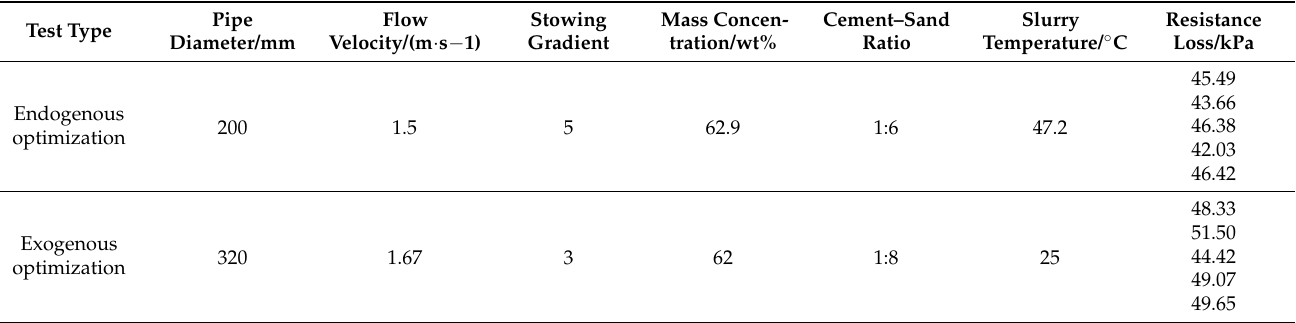
Table 12. Verification test